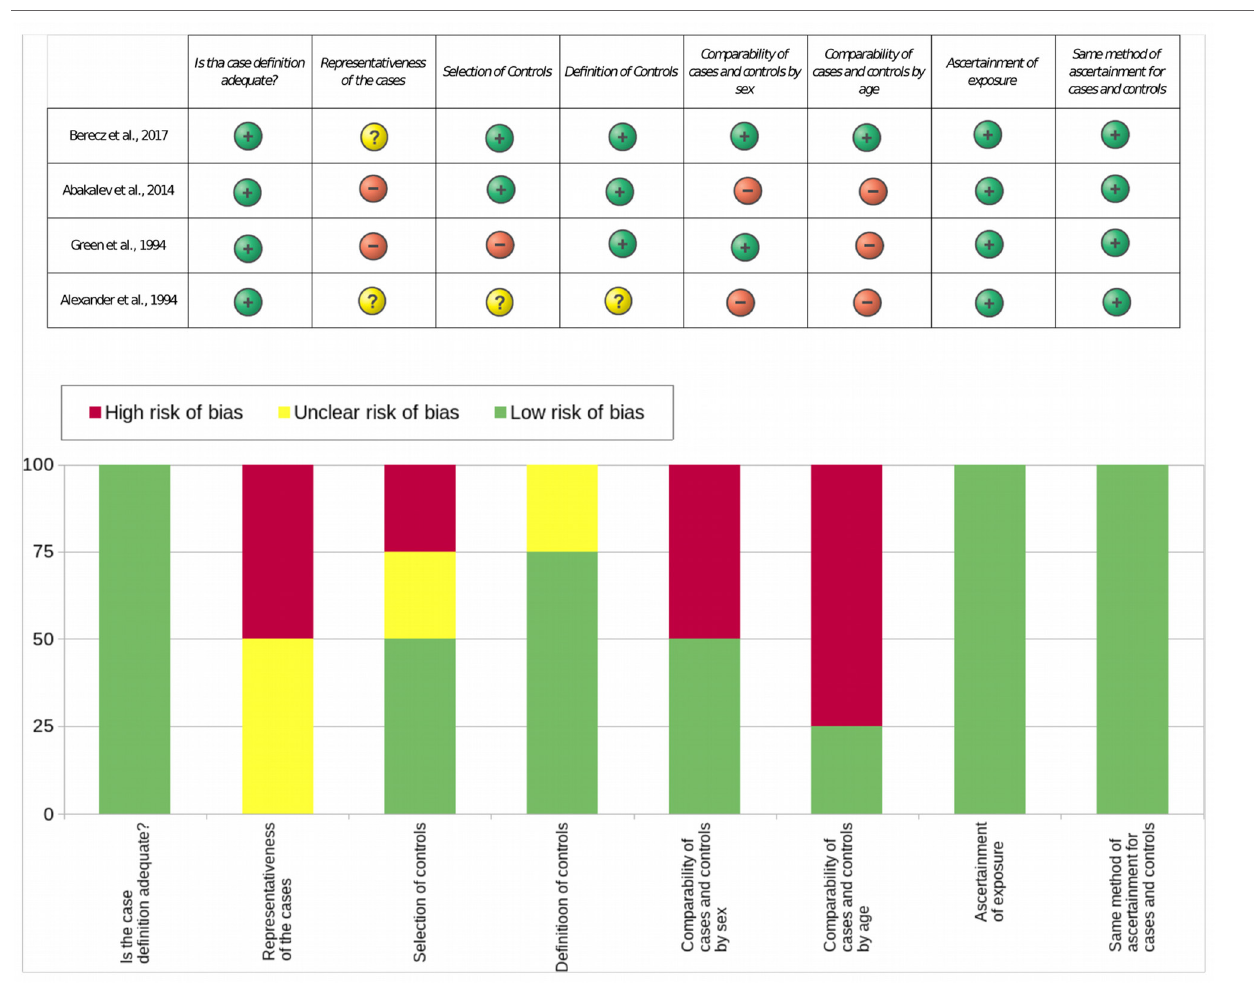
TABLE 3 | Results of the assessment of the quality of included studies by